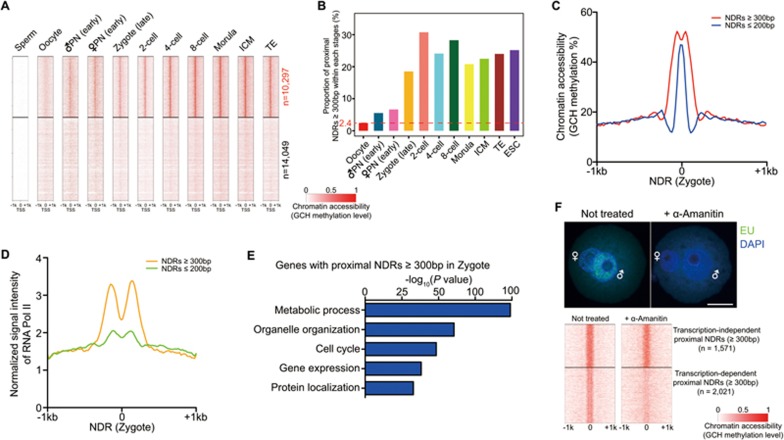
Chromatin remodeling dynamics of promoter regions during mouse preimplantation development. (A) Dynamics of chromatin accessibility around TSS of 24 346 RefSeq genes during mouse preimplantation development. Blastomeres within each stage were merged together and averaged GCH methylation level was calculated for this analysis. (B) Bar plot of the proportion of proximal NDRs with over 300 bp width during preimplantation development. (C) Averaged GCH methylation level around NDRs with distinct width in the zygote. (D) Presumptive binding of RNA Pol II around NDRs with distinct width in the zygote. Published RNA Pol II binding information of mouse ES cells by ChIP-seq was used for this analysis. (E) GO analysis of corresponding genes with their proximal NDRs over 300 bp in width. (F) Inhibition of transcriptional activity in mouse zygote and identification of transcription-dependent wider proximal NDRs after fertilization. Scale bar, 25 μm.